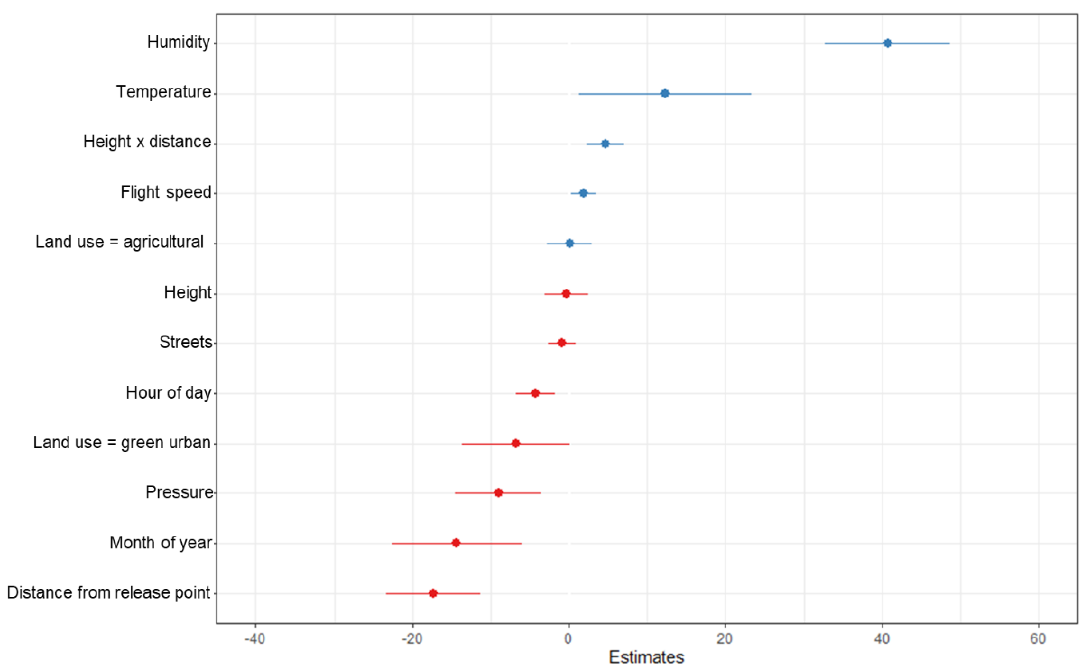
Figure 5. Graphical summary of the linear mixed effects regression model estimates. Dots are the coefficient estimates for each predictor (reported on the left), with lines representing the standard errors. Red and blue show negative and positive values, respectively.